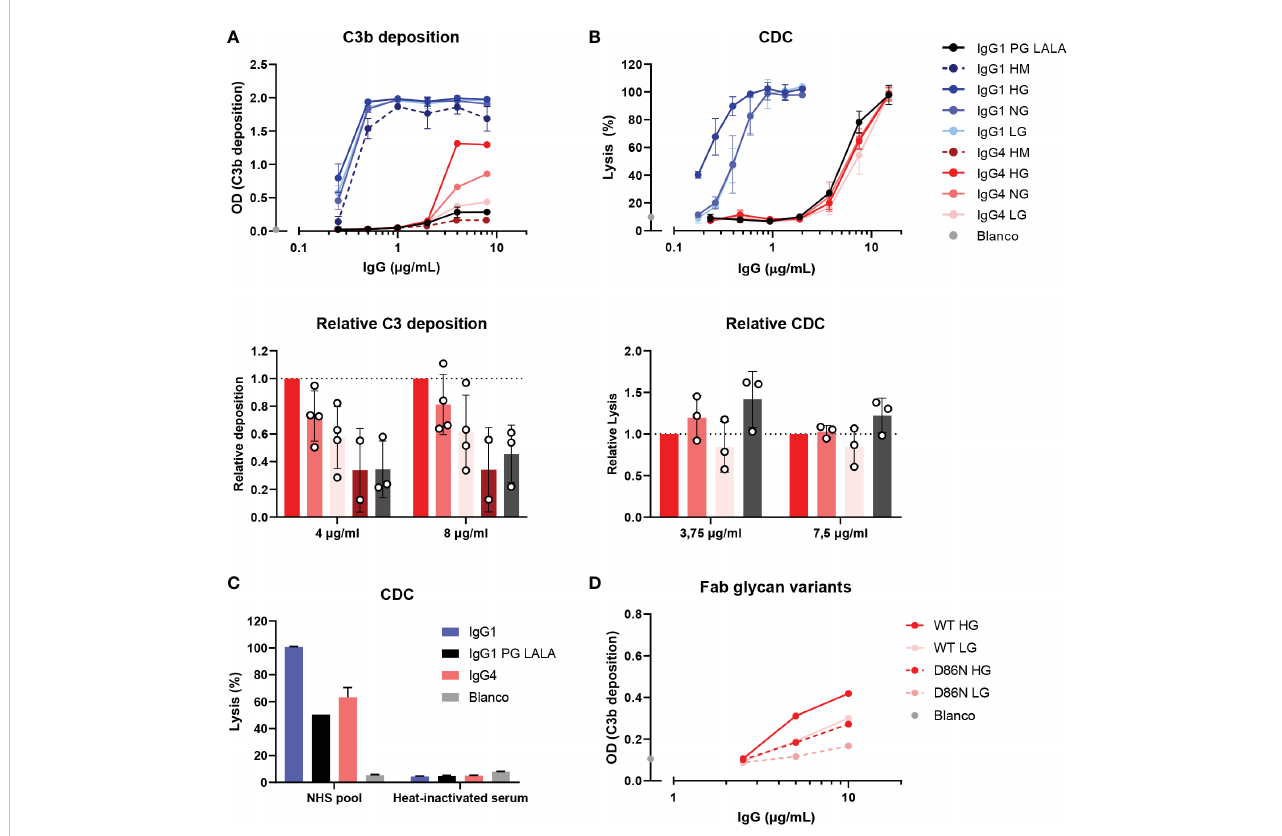
FIGURE 3 IgG4 glycovariants can induce C3b deposition to different extent. (A) C3b deposition induced by anti-biotin IgG1 and IgG4 glycovariants (high mannose (HM), high galactose (HG), normal galactose (NG) and low galactose (LG)), and IgG1 PG-LALA in the presence of biotinylated human serum albumin (240 m M biotin) and 2.5% human serum. Relative C3b deposition of the IgG4 glycovariants at concentrations 4 µg/mL and 8 µg/mL was normalized to IgG4 HG, which was set to 1 (dashed line), is shown as bar graphs. (B) Percentage of complement-mediated lysis of biotinylated human red blood cells (2.5 mM biotin) by the anti-biotin IgG1 and IgG4 glycovariants. The percentage of lysis was calculated based on the 100% lysis control (red blood cells with saponin). The percentage of complement-mediated lysis of the IgG4 glycovariants at concentrations 3.75 µg/mL and 7 µg/mL normalized to IgG4 HG is shown as bar graphs. Kruskal-Wallis test with Dunn ’ s multiple comparisons test of the IgG4 glycovariants was performed. (C) To test unspeci fi c complement-dependent cytotoxicity (CDC), anti-biotin IgG1, IgG4 and IgG1 PG-LALA (eliminated Fc-mediated effector functions) were tested in the presence of biotinylated RBCs and 10% normal or heat-inactivated human serum. (D) C3b deposition induced by anti-trinitrophenyl (TNP) IgG4 glycovariants variants (HG and LG), which were produced as wild type IgG4, and a variant with D86N substitution in the light chain to introduce an additional glycosylation site in the Fab region. All experiments were performed at least three times, shown are representative fi gures for the C3b deposition and the mean ± standard deviation for the lysis